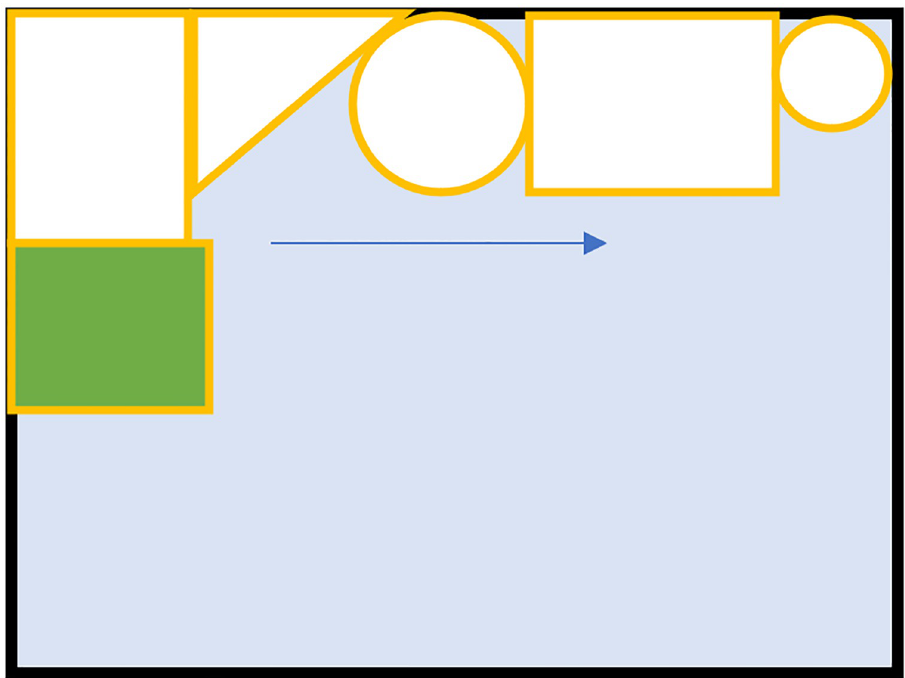
Fig 7. The way to reduce computation. The green part is the part to be packed, and the beige parts are the parts in the bind. To reduce the calculation time, the convolution operation is only performed along the edge of the parts in the bin to obtain the effective position